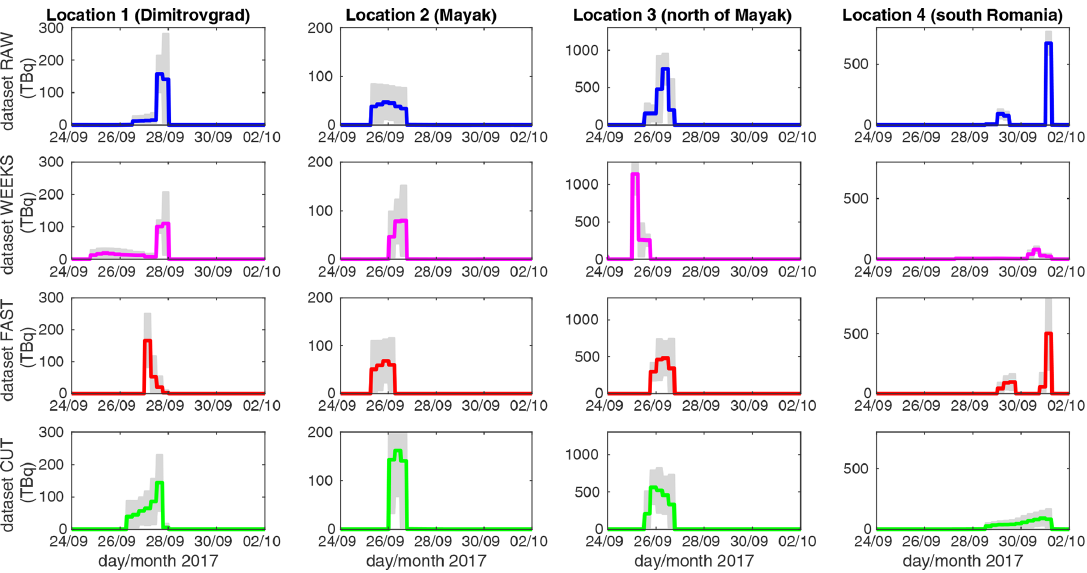
Figure 7. Estimated source terms from the locations considered in Fig. 6 (indicated in the titles of each column) for the RAW (blue lines), WEEKS (magenta lines), FAST (red lines), and CUT (green lines) datasets. The estimated source terms are accompanied by the 95% uncertainty regions (gray-filled regions). Note that the vertical axis has a different scales for each location.